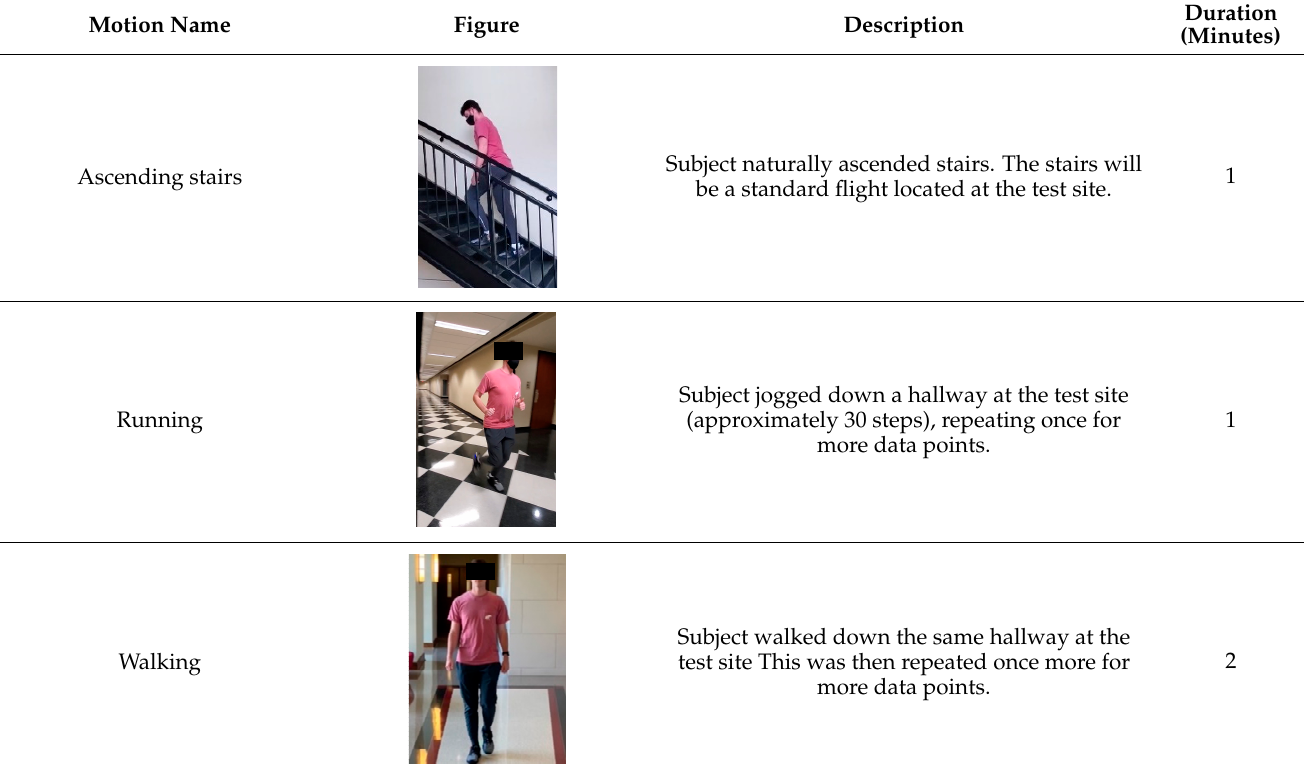
Table 2. Detailed description of all recorded motions.